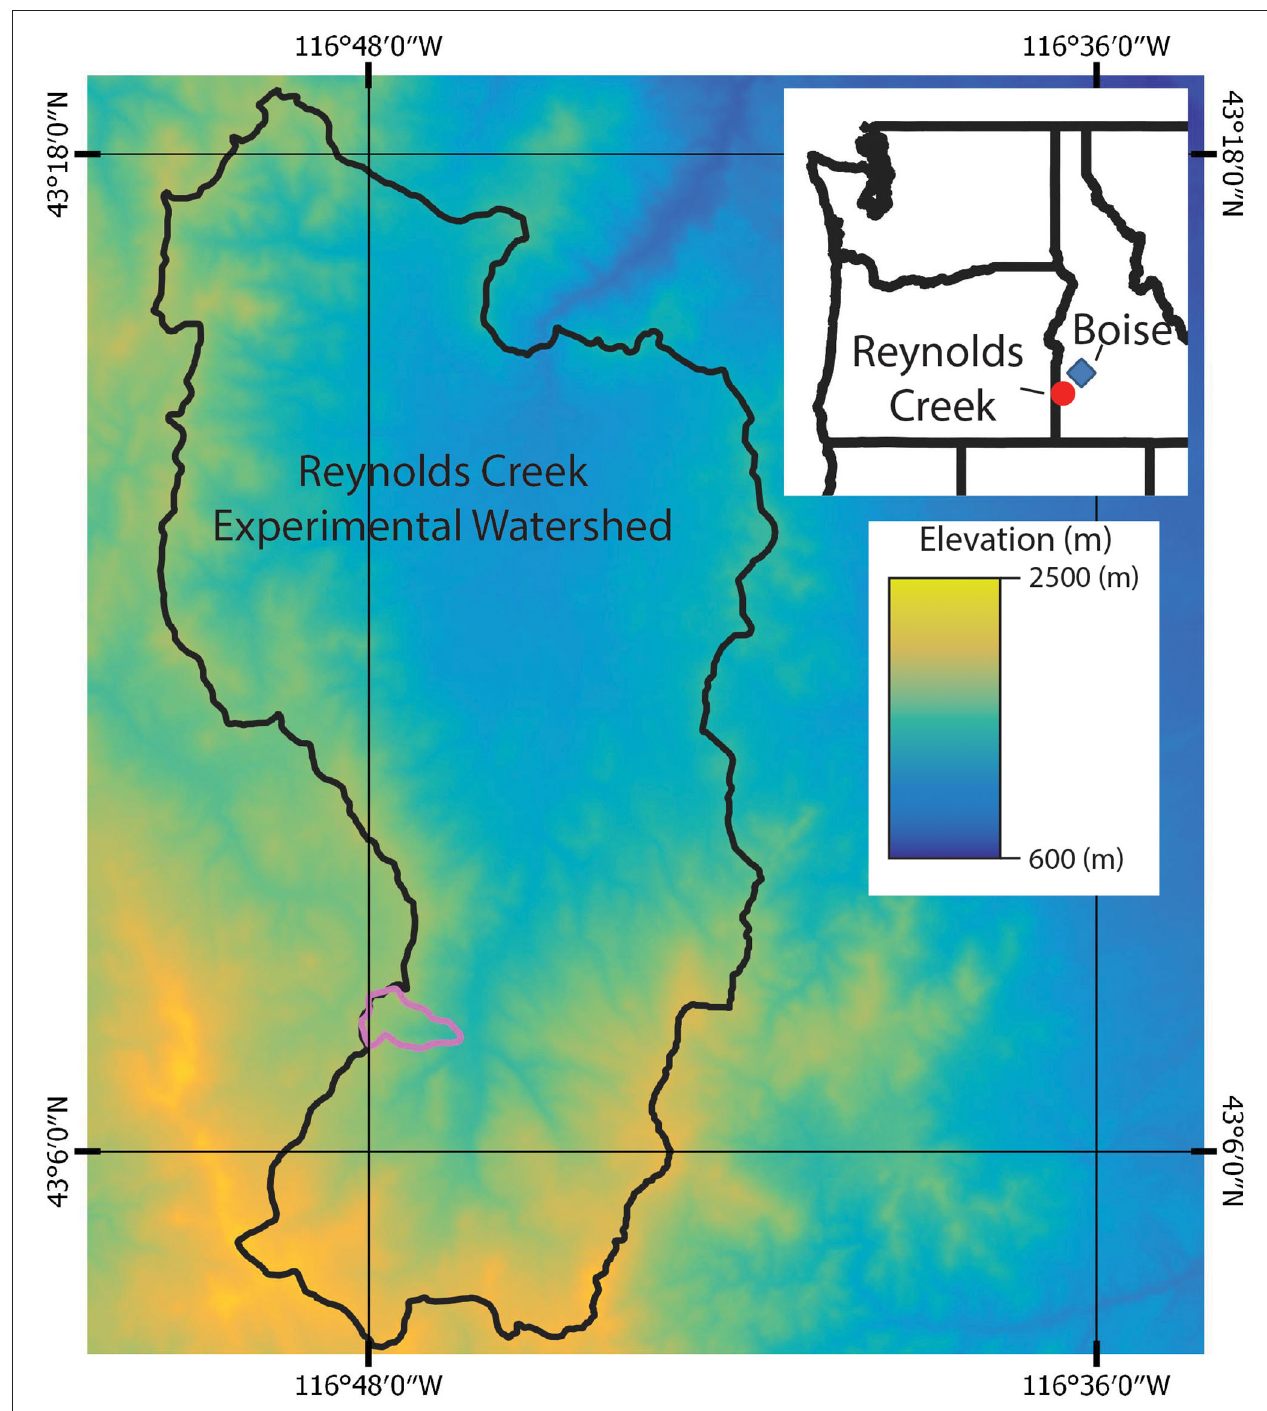
FIGURE 1 | Overview of the Reynolds Creek Critical Zone Observatory and its location in southwestern Idaho. The study site is outlined in purple and a digital elevation model overlays a satellite image of the Reynolds Creek watershed.